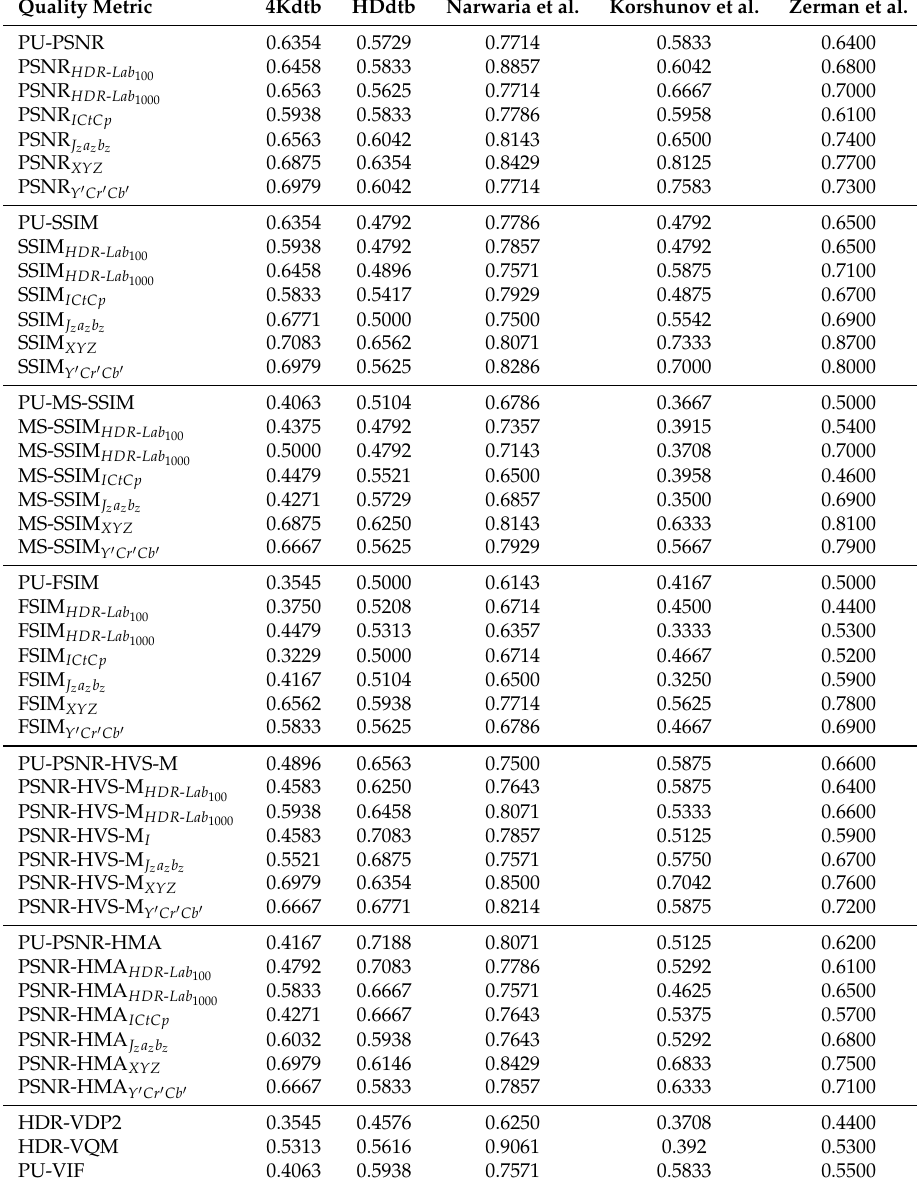
Table A5. OR of the different color-blind quality metrics on the considered databases. Quality